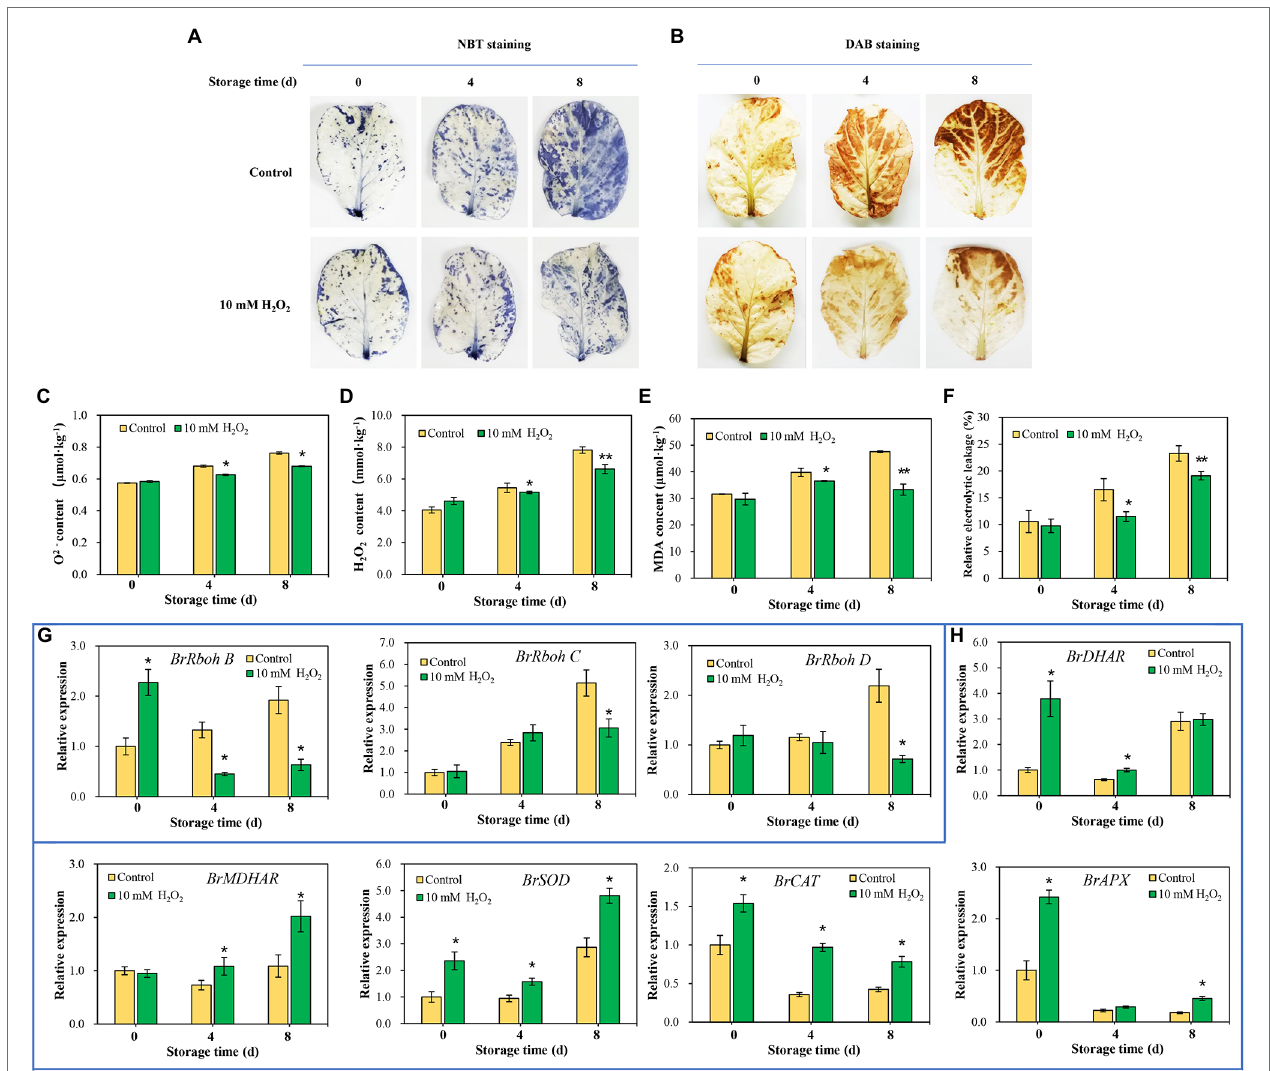
FIGURE 6 | Effects of preharvest H 2 O 2 treatment on reactive oxygen species (ROS) accumulation and antioxidant capacity of leaves during storage. Location of O 2 (A) and H 2 O 2 (B) in leaves were detected with nitro blue tetrazolium (NBT) and 3,3 ′ -diaminobenzidine (DAB), respectively. Changes in the contents of O 2 − (C) , H 2 O 2 (D) , malondialdehyde (MDA; E ), and relative electrolytic leakage (F) at days 0, 4 and 8 after harvest. The relative expression levels of ROS biosynthesis genes, including BrRbohB , BrRbohC , and BrRbohD (G) , and ROS scavenging-associated genes, including BrDHAR , BrMDHAR , BrSOD , BrCAT , and BrAPX (H) during storage. Error bars represent one SD. Asterisks indicate that the mean values of H 2 O 2 treatment are significantly different from those of the control (* p < 0.05, ** p < 0.01), according to Duncan’s multiple range